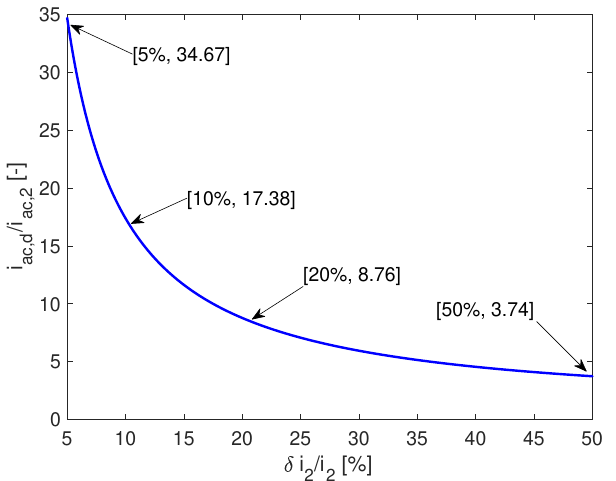
Figure 6. Comparison of the AC components introduced into the second stage by both the classical and NEC boost solutions ( d =